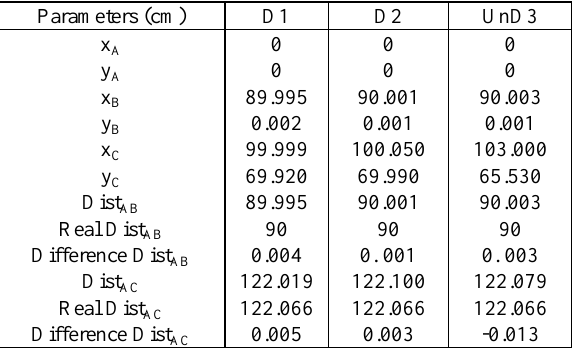
Table 6 Distance